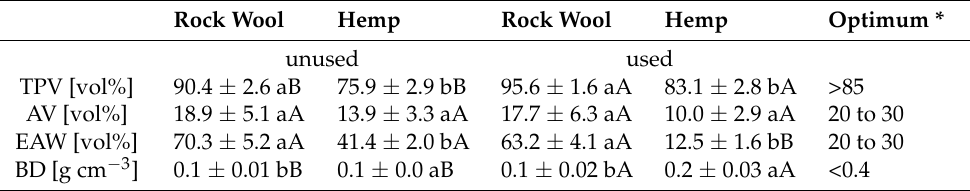
Table 1. Physical properties of substrates before and after their use in hydroponic tomato cultivation. Rock Wool Hemp Rock Wool Hemp Optimum * unused used TPV [vol%] 90.4 ± 2.6 aB 75.9 ± 2.9 bB 95.6 ± 1.6 aA 83.1 ± 2.8 bA >85 AV